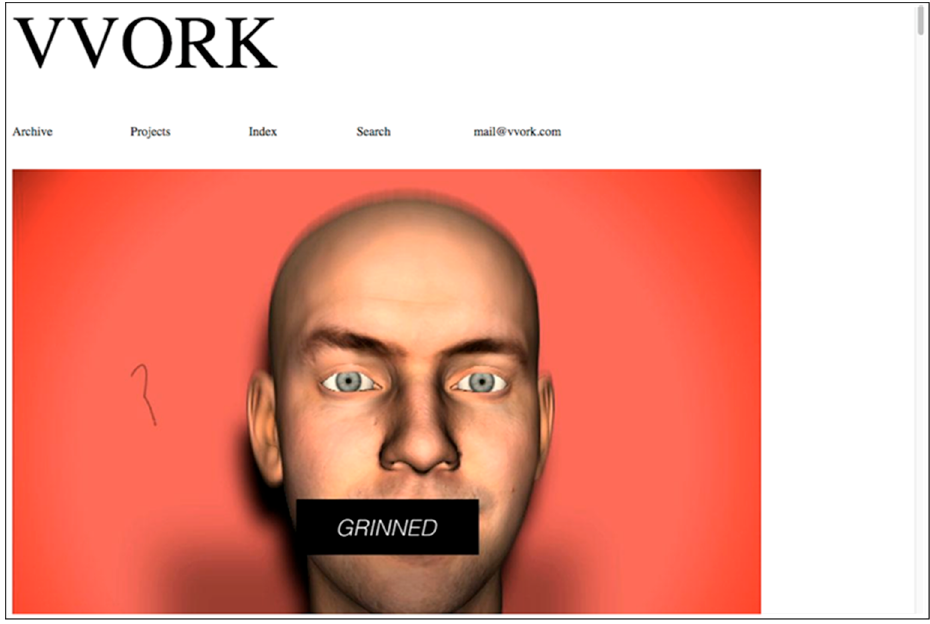
Figure 7. VVORK , 2006–2012. Screenshot of 3D index page, 2019. @ VVORK, 2019.